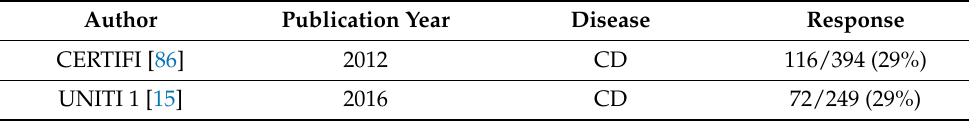
Table 3. Efficacy of ustekinumab in primary failures to anti-TNF